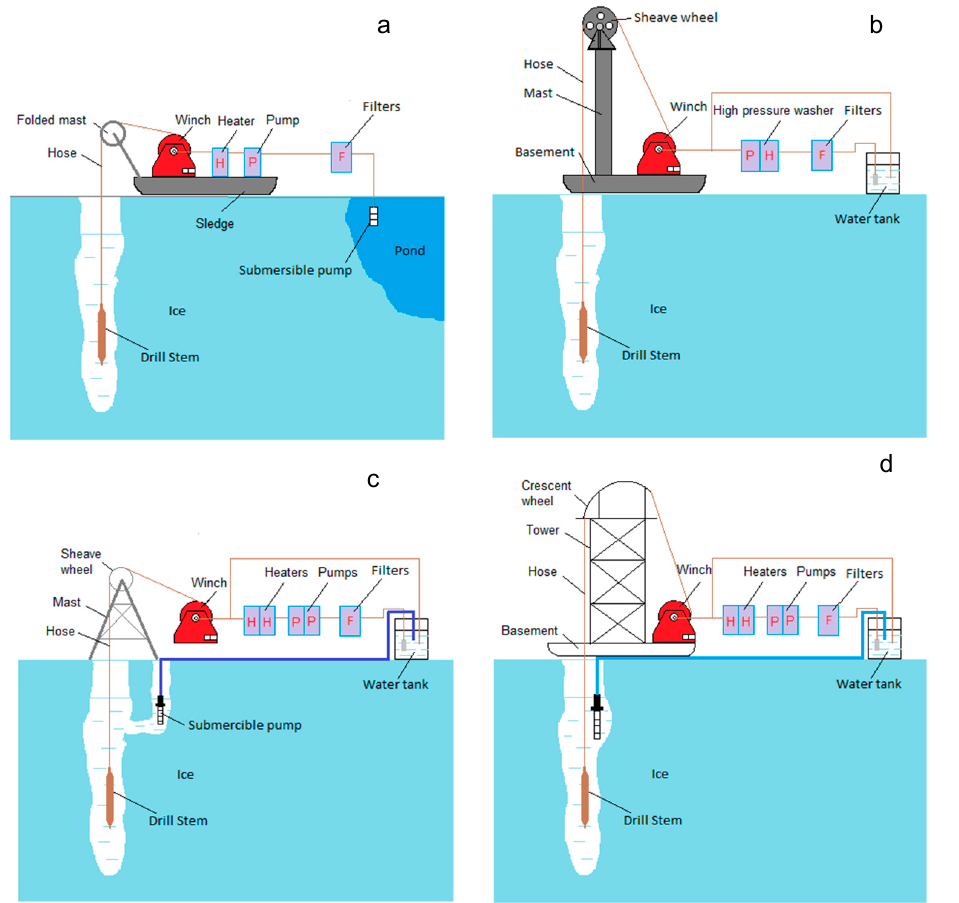
Figure 2. General schematics of typical hot-water drill systems depending on approaches to obtain water for drilling and to heat/pump water, as well as configurations for the mast and sheave wheel: ( a ) surface runoff water at mountain glaciers and the Greenland Ice Sheet that melt in the summer with folded mast, heater, and pump; ( b ) water melted in containers or tanks from surface snow and ice with dismountable mast and heater/pump unit combined in high-pressure washer; ( c ) water from supplementary borehole drilled nearby and connected with the main borehole by a subsurface cavity, stationary mast, and series of heaters/pumps; ( d ) water pumped out directly from the drilled borehole with tower, crescent wheel, and series of heaters/pumps.